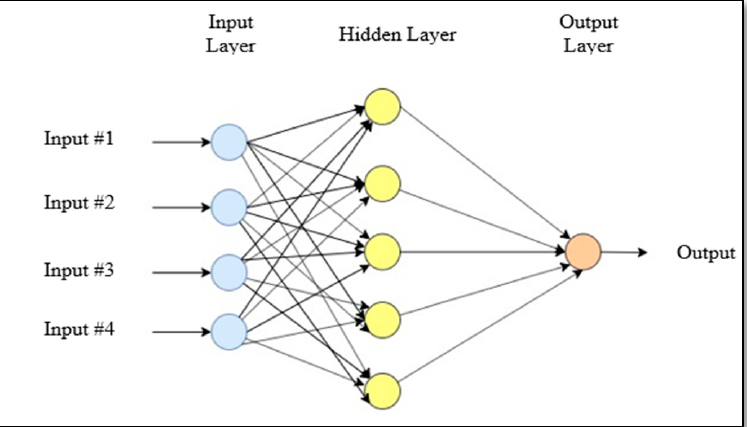
Figure 2. Multilayer perceptron network with single output.